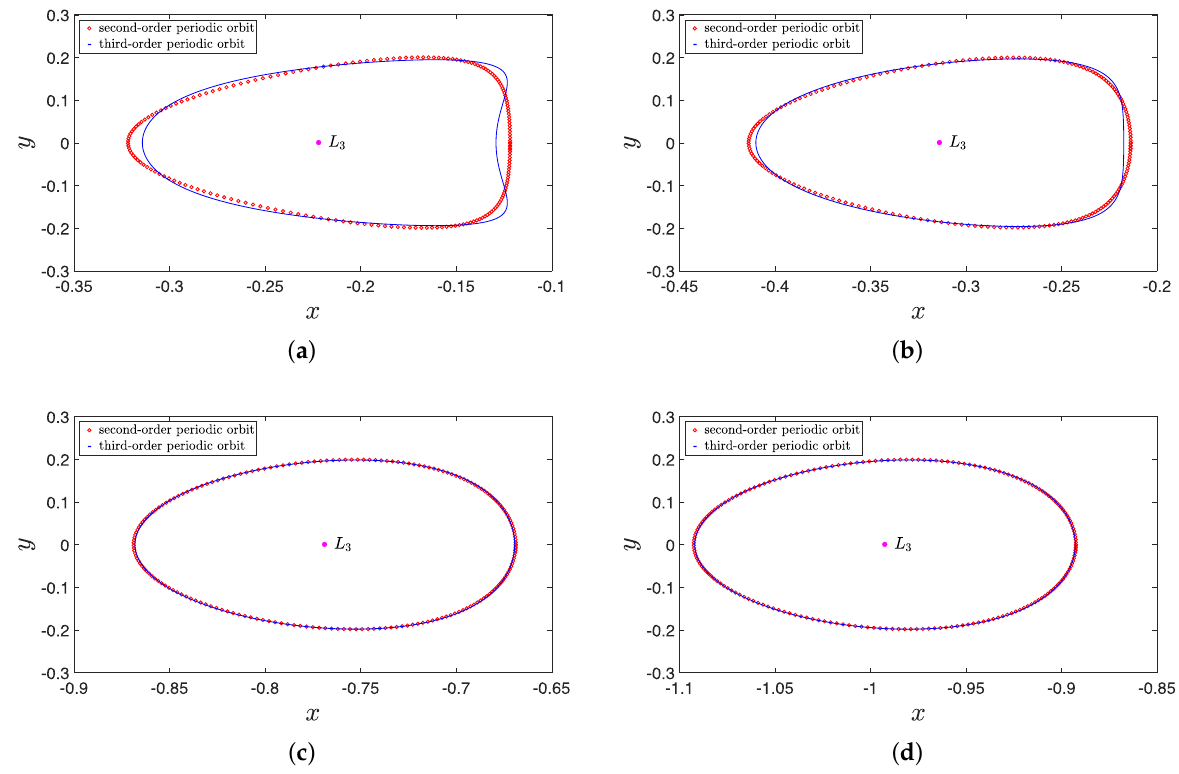
Figure 6. Approximate periodic orbits near the Lagrangian point L 3 when ( a ) γ = 0.05, ( b ) γ = 0.1, ( c ) γ = 0.6, and ( d ) γ = 1,